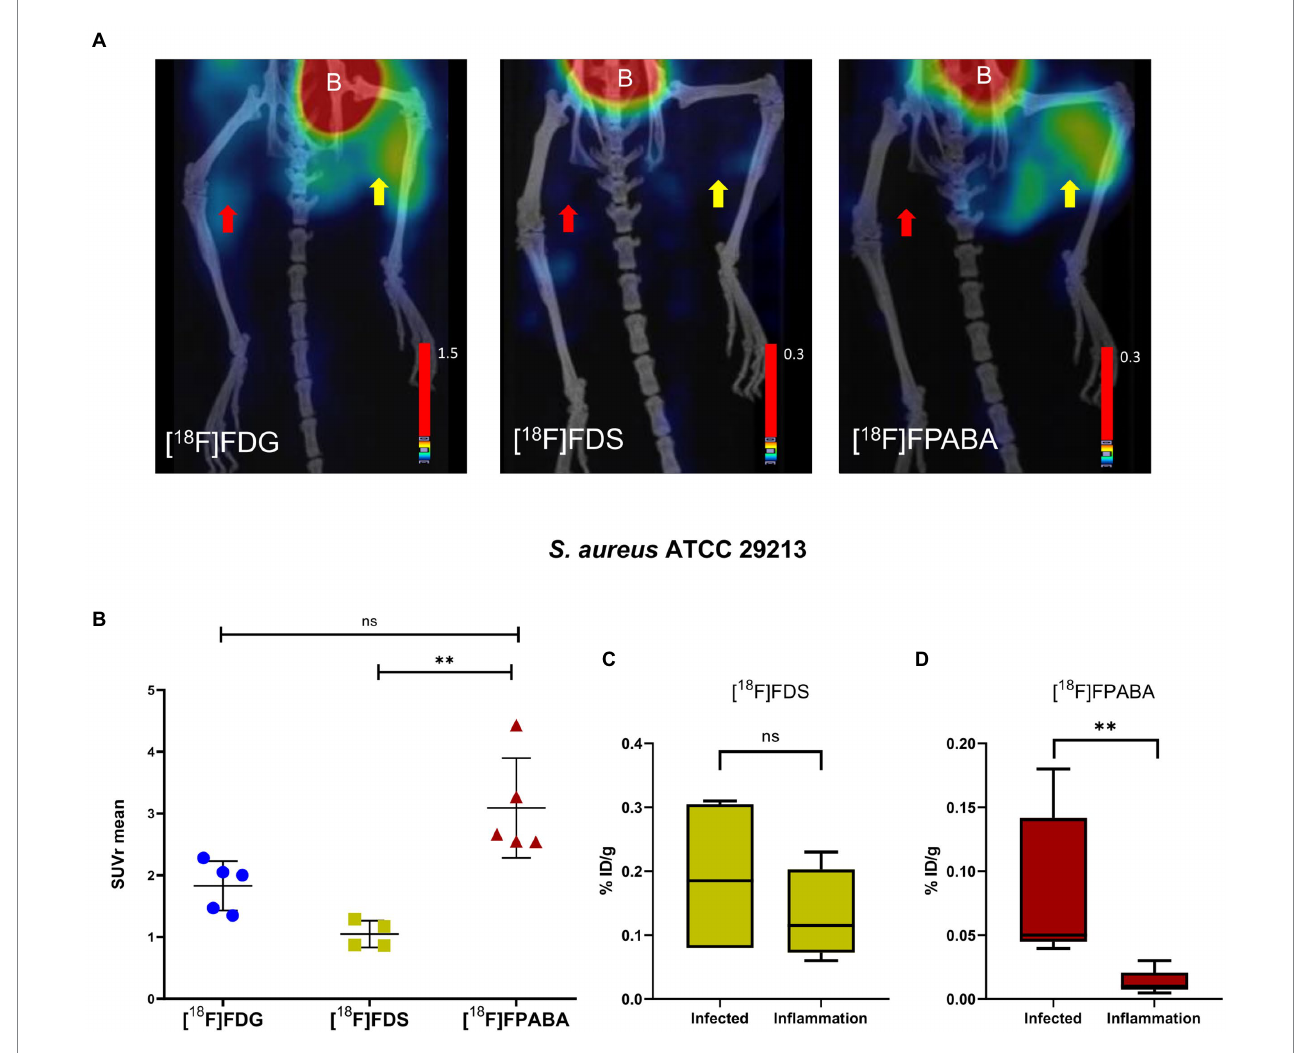
FIGURE 6 Staphylococcus aureus myositis infection and inflammation of hindlimbs. (A) PET/CT imaging with [ 18 F]FDS ( n = 4) after 120 min, [ 18 F]FDG ( n = 5), and [ 18 F] FPABA ( n = 4) after 60 min of acquisition. The right limb was infected with exponentially growing bacteria (yellow arrow); the left limb was injected with heat-killed bacteria (red arrow). B = bladder. (B) Comparison of mean SUVr for uptake of [ 18 F]FDG, [ 18 F]FDS, and [ 18 F]FPABA in infected and inflamed muscle tissue. Represented as mean ± SD. ns, not significant ( p > 0.05), * p ≤ 0.05, ** p ≤ 0.01. Kruskal-Wallis multiple-comparison test. (C) Ex vivo data of % injected dose of [ 18 F]FDS per gram of infected and inflamed tissue (%ID/g). (D) Ex vivo data of % injected dose of [ 18 F]FPABA per gram of infected and inflamed tissue (%ID/g). ** p ≤